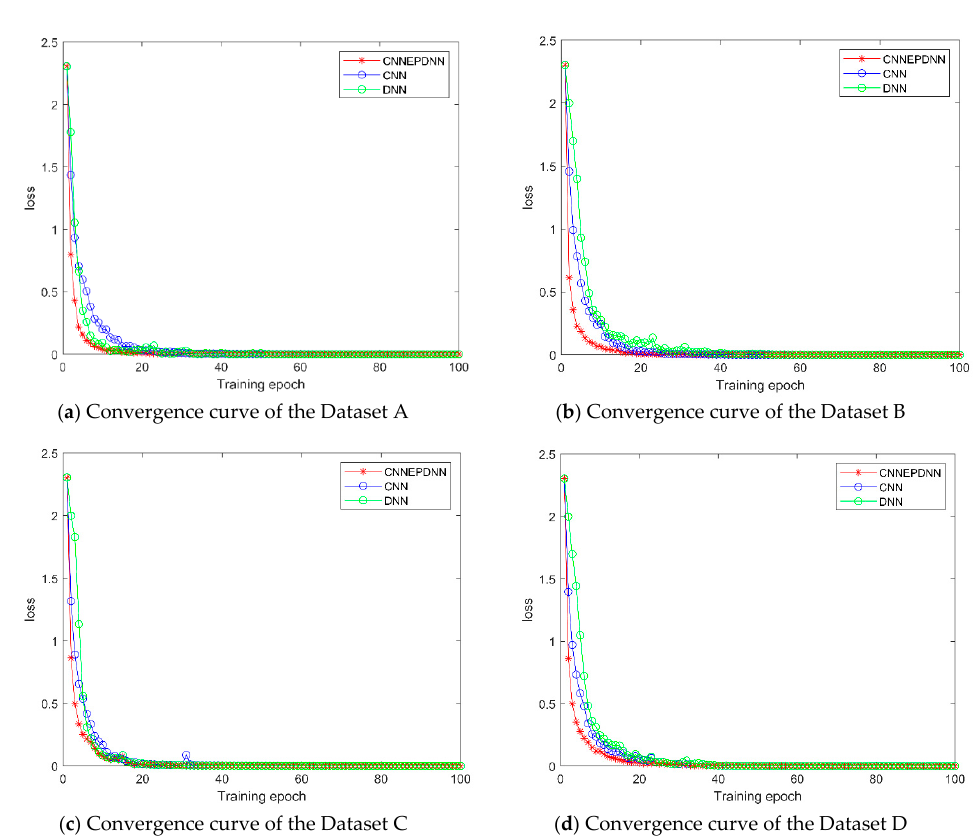
Figure 7. Comparison of loss function between CNN, DNN and CNNEPDNN. (a), (b), (c), (d) are the convergence curve of training loss function on dataset A, B, C and D, respectively.